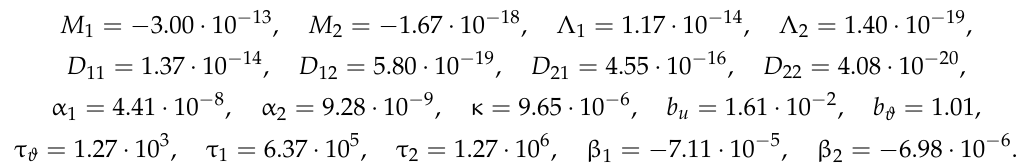
η ; and ( b ) temperature increment ϑ . 2